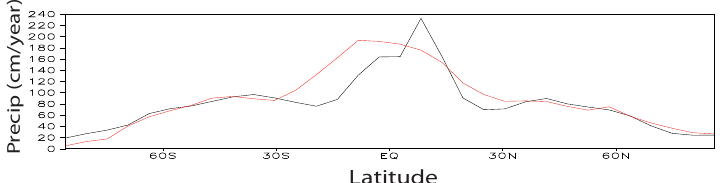
Fig. 10. Zonal mean precipitation (cm/year) averaged over the period 1980-2000 in Xie and Arkin (1996 and updates) dataset (black) and in LOVECLIM1.2 (red).